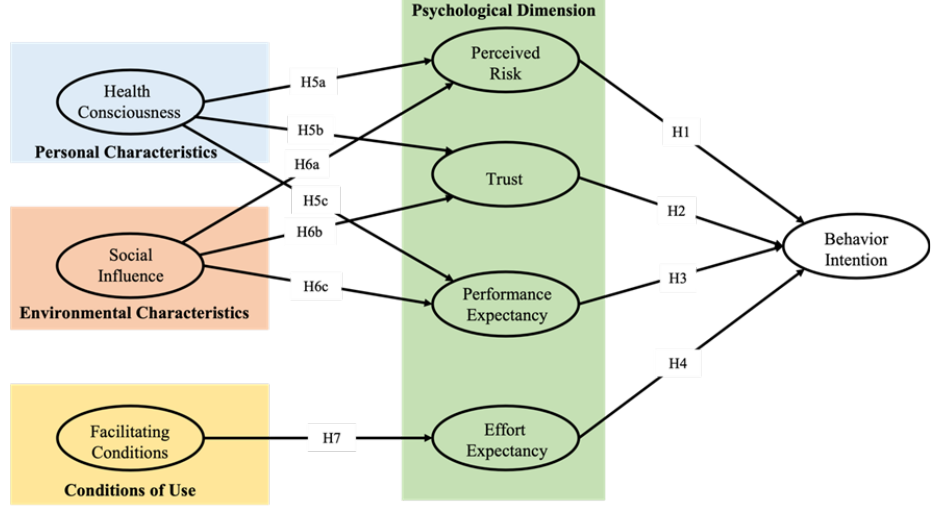
Figure 1. Revised model to be tested for hypotheses (H).